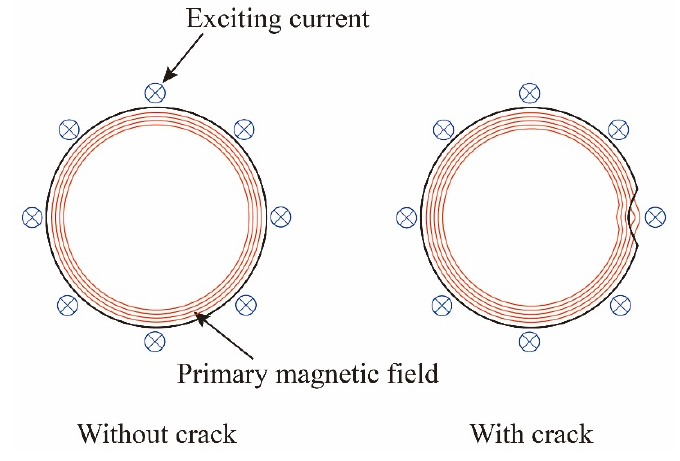
Figure 5. Schematic of magnetic flux leakage.